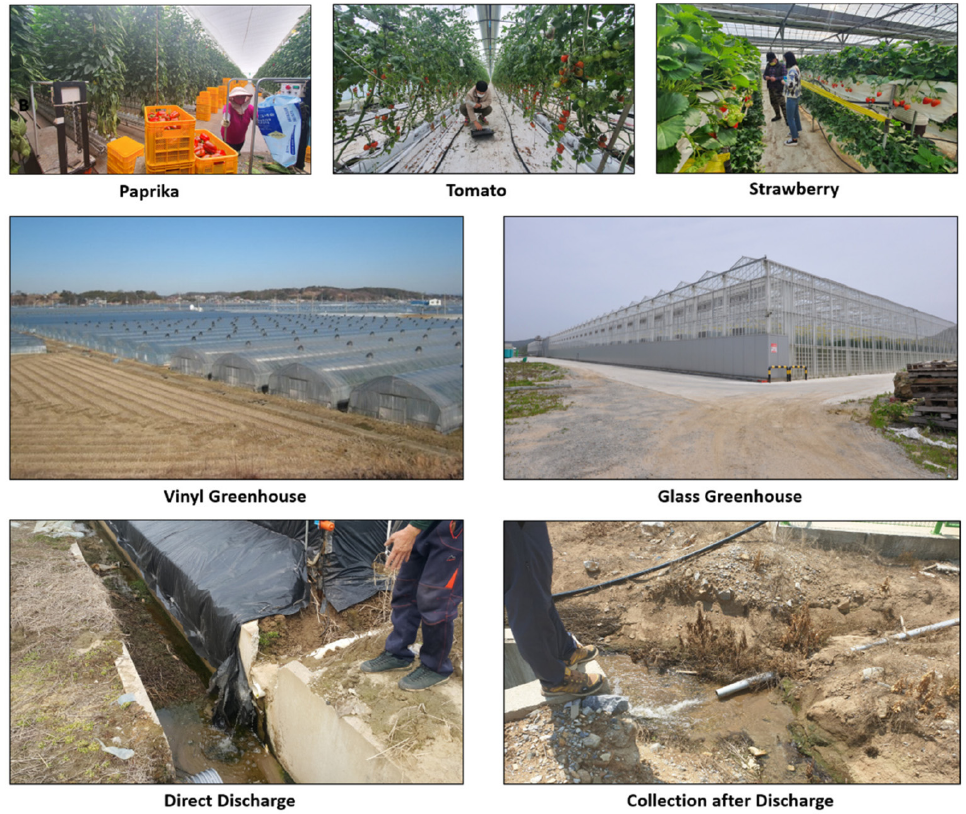
Figure 1. Types of study crop, greenhouse, and discharged drainage.